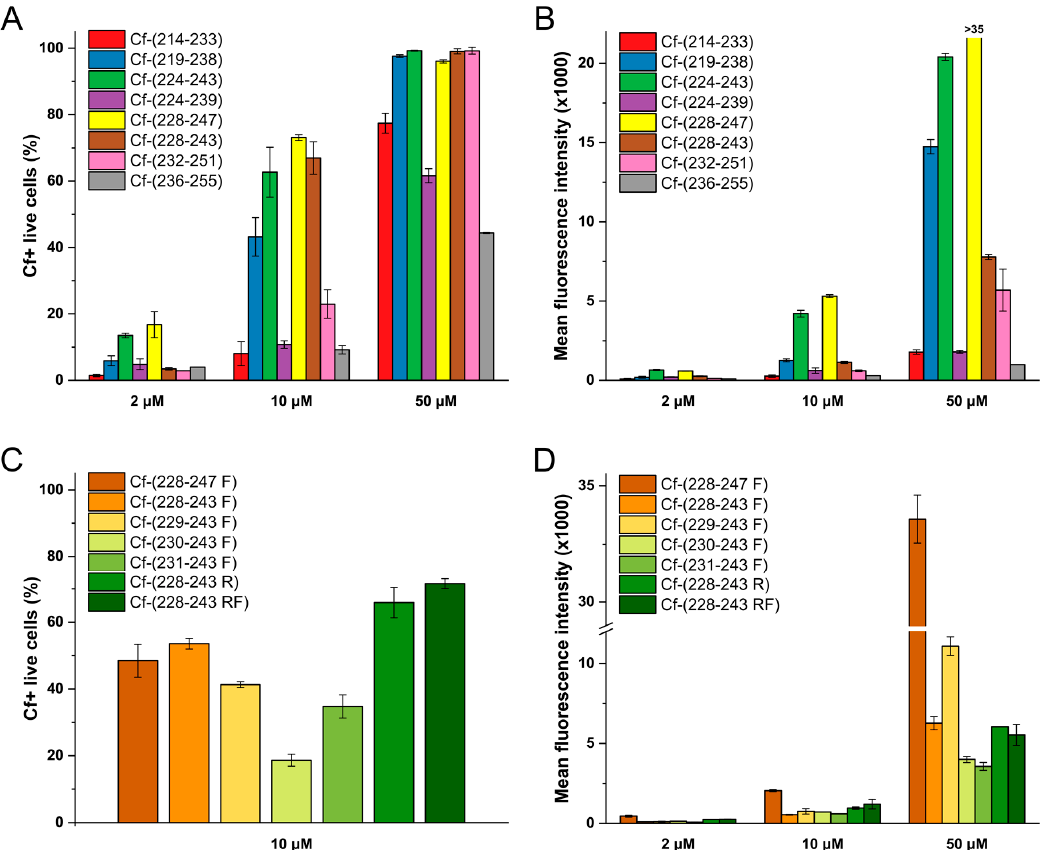
Figure 6. Internalisation of synthetic Cf-HSV-1 gD peptides into SH-SY5Y neuroblastoma cells measured by flow cytometry. ( a ) Internalisation of Set III peptides at c = 2, 10 and 50 μ M, percentage of Cf-positive live cells, ( b ) internalisation of Set III peptides at c = 2, 10 and 50 μ M, mean fluorescence intensity ( c ) internalisation of Set IV peptides at c = 10 μ M, percentage of Cf-positive live cells, ( d ) internalisation of Set IV peptides at c = 10 μ M, mean fluorescence intensity. Graphs were plotted using Origin 2018 (OriginLab, Northampton, Massachusetts, USA).